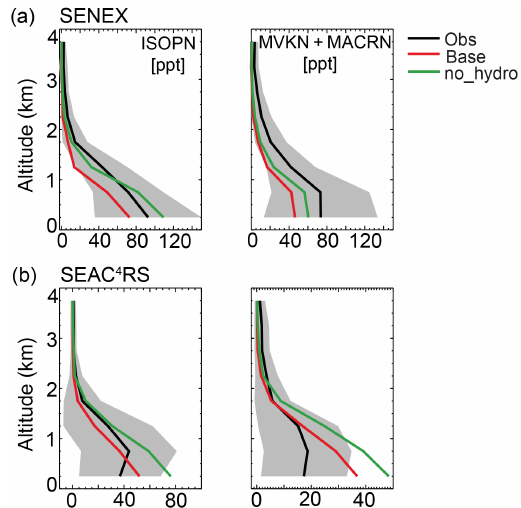
Figure 2. Mean vertical profiles of ISOPN and MVNK + MACRN during (a) SENEX and (b) SEAC 4 RS over the Southeast US (25– 40 ◦ N, 100–75 ◦ W). Black lines are the mean of observations. Red and green lines are the mean of modeled results with hydrolysis of ISOPNB and without hydrolysis of alkyl nitrates, respectively. Gray shades are 1 standard deviation ( ± σ ) of averaged profiles of the measured